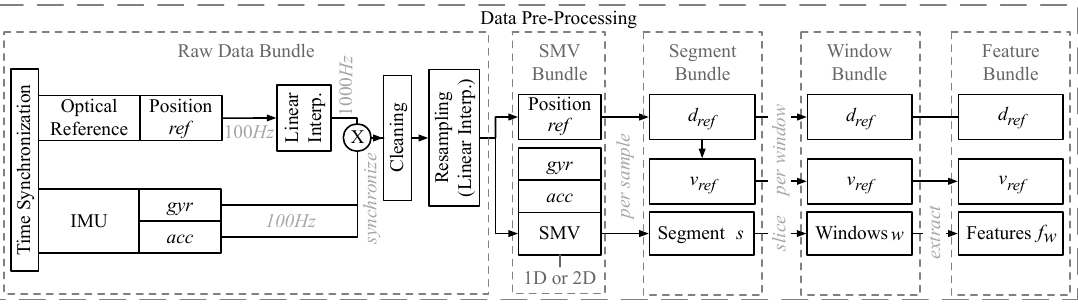
Figure 1. A zoomed-in view of the pre-processing